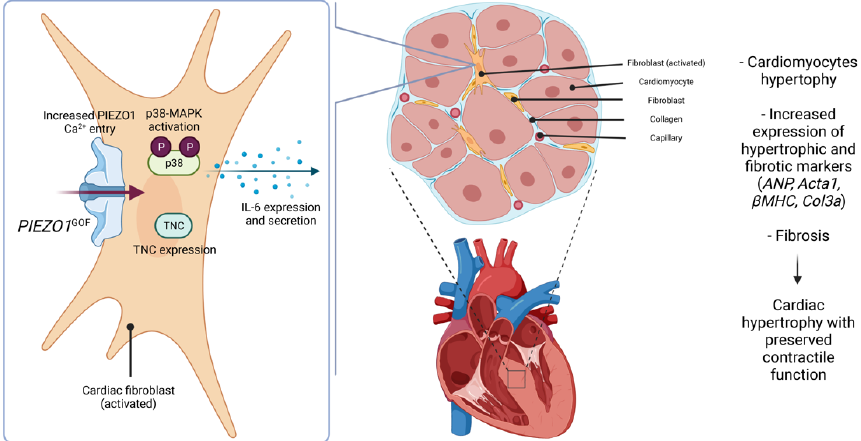
Figure 5. Schematic of proposed mechanism by which PIEZO1 gain-of-function (GOF) mutation causes cardiac remodelling. The M2241R PIEZO1 GOF mutation increased PIEZO1-dependent calcium entry and amplified downstream p38, IL-6 and TNC signalling in cardiac fibroblasts, which correlated to global hypertrophic and fibrotic remodelling of the heart.